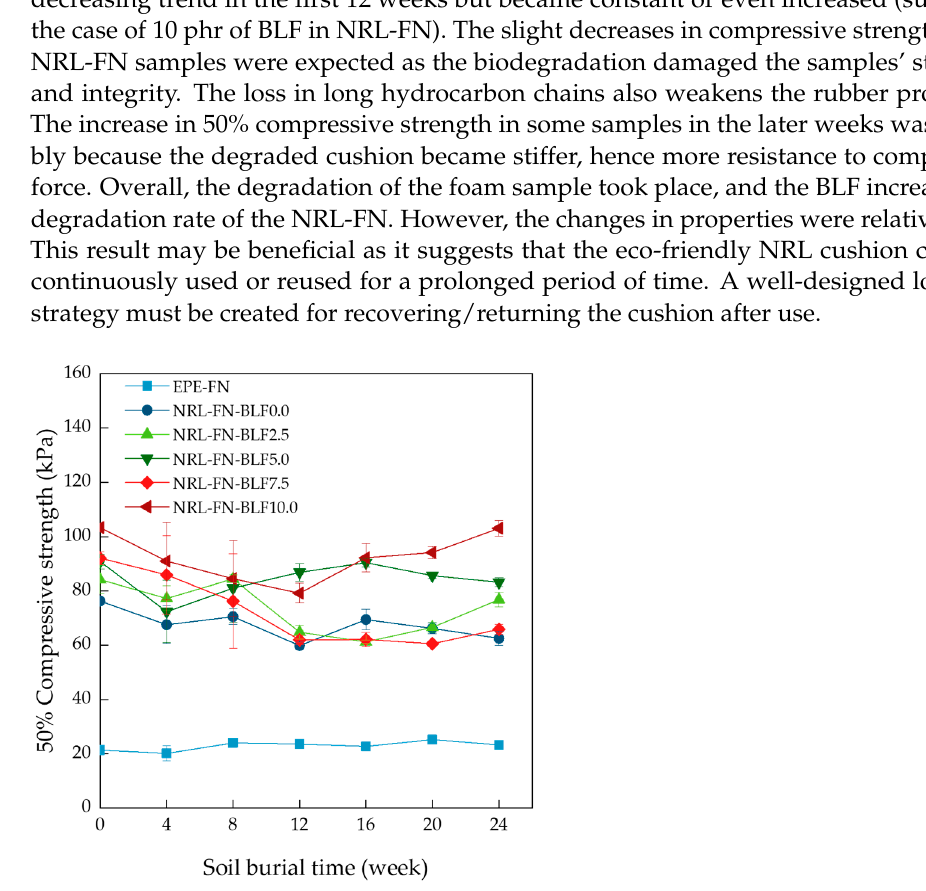
Figure 16. FTIR spectra of NRL foam composite at various BLF contents after soil burial for 24 weeks.